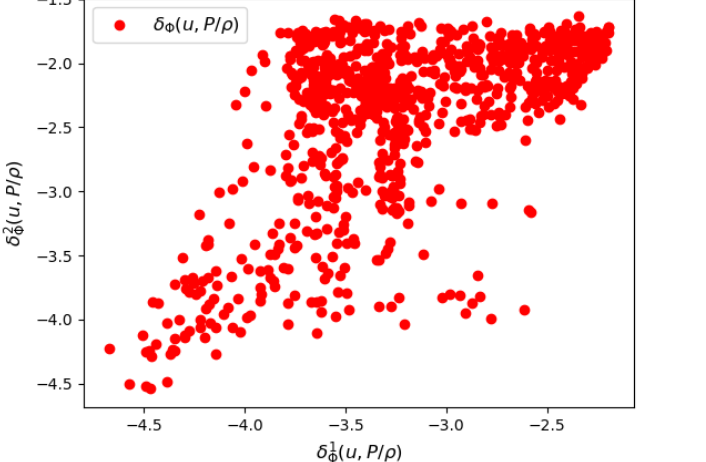
Figure 7. Mesh n°1: The first two components of the parametrized logarithm of variance by the VAE encoder.